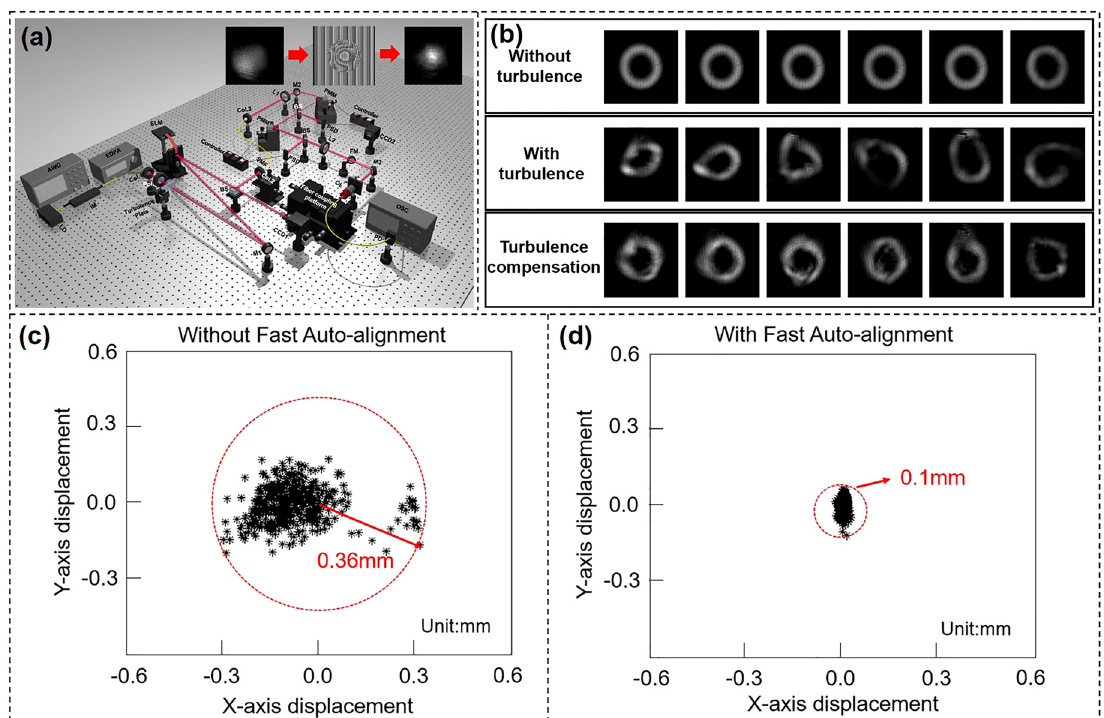
Figure 17: Turbulence compensation based on auto-alignment system. (a) Experimental setup of free-space adaptive optics communication link against atmospheric turbulence and device vibration. PMM: piezo mirror mount; SMF: single-mode fiber; PSD: position sensing detector; FM: flip mirror; OL: objective lens; OSC: oscilloscope. (b) Intensity profiles of the OAM beam ( l = + 3) recorded by 1550 nm camera under three different conditions: without turbulence, with turbulence and without compensation, with turbulence and with compensation. (c) Measured beam displacements without fast auto-alignment system. (d) Measured beam displacements with fast auto-alignment system [25]. Reprint permission obtained from